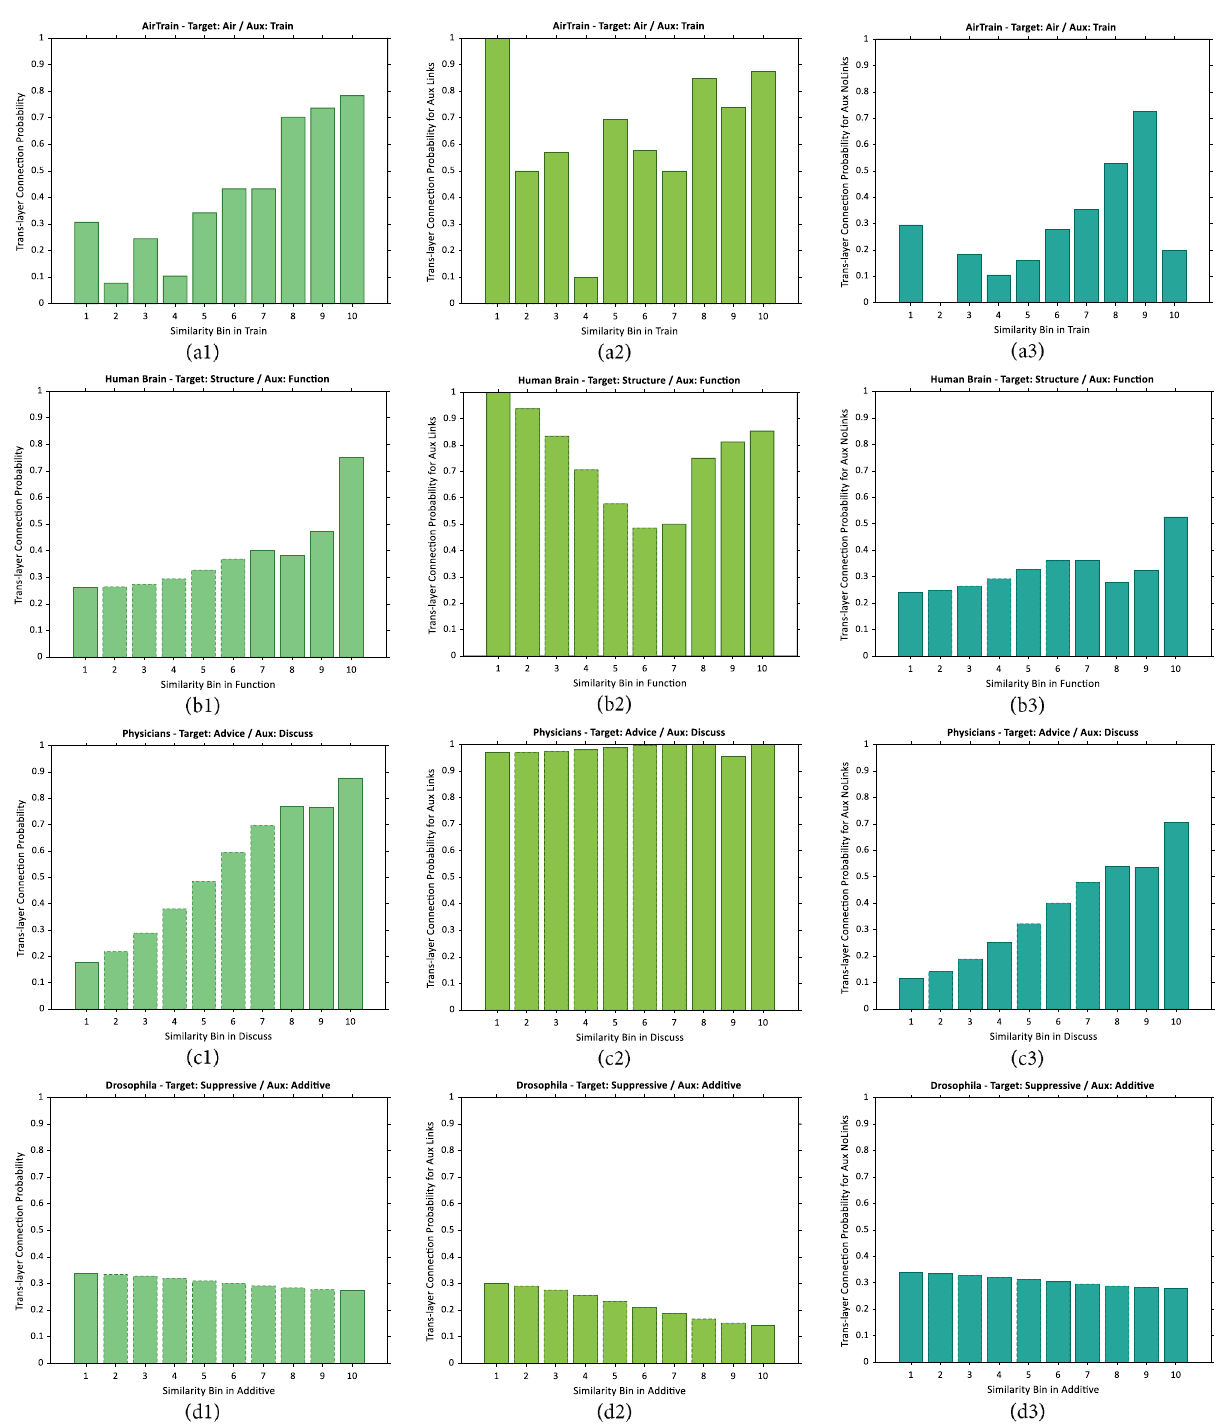
Figure 2. Empirical trans-layer connection probability in auxiliary layer bins. ( a1 – d1 ) Trans-layer connection probability of all node pairs, ( a2 – d2 ) Trans-layer connection probability of node-pairs connected in auxiliary layer, ( a3 – d3 ) Trans-layer connection probability of node-pairs unconnected in auxiliary layer, for sample duplexes of 4